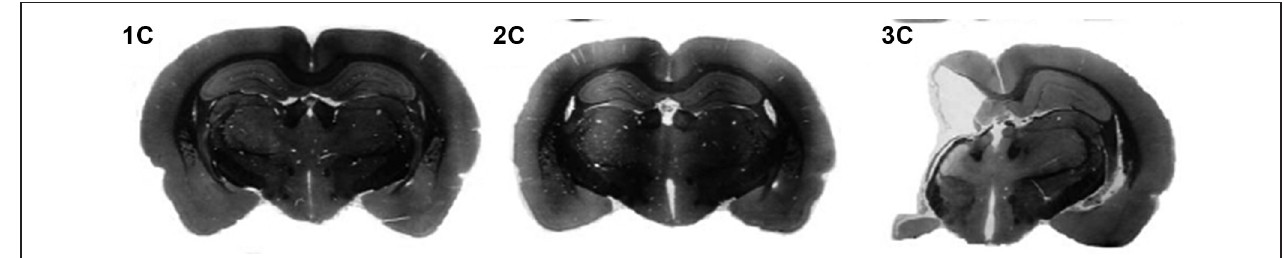
FIGURE 4 | Coronal cross-sections (nissl) from exemplar adult rats following sham (1C), P1 HI (2C) or P7 HI (3C) injuries. Taken from McClure, M., Threlkeld, S., Rosen, G. and Fitch, R.H. (2006). Rapid auditory processing and learning deficits in rats with P1 versus P7 neonatal hypoxic-ischemic injury. Behav. Brain Res. 172,